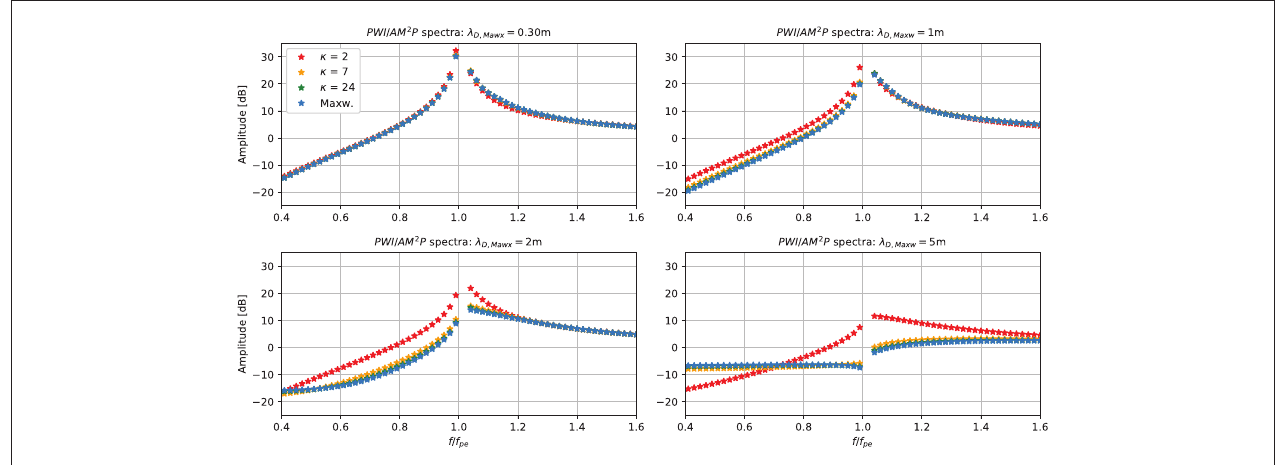
FIGURE 6 | Modeled PWI/AM 2 P mutual impedance spectra for different λ D , Maxw (from 30 cm to 5 m) in a plasma modeled by a kappa evdf ( κ = 2, 7, 24) and a Maxwellian evdf ( κ ). The amplitude is expressed in 20 log 10 and the frequency is normalized by the electron plasma → +∞